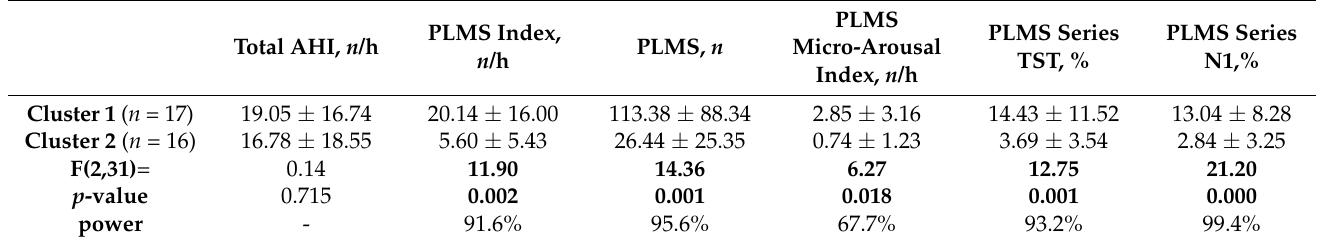
Table 4. Centroids of the two clusters.